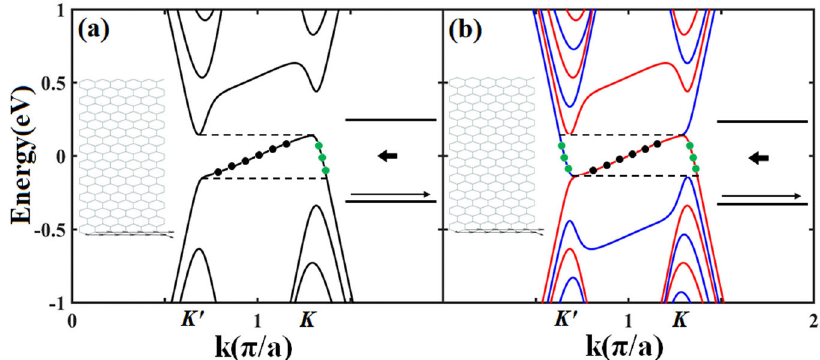
Fig. 6 The band structure of one case of Type-2. a U 1 = 0.2 t . b M 1 = 0.2 t . Inset: local current distribution ( E = 0.03 eV) and schematic diagram of corresponding edge states. The black bands (arrows) denote the spin degeneracy case, and the red (blue) bands denote the spin-up (down) case. Other fi xed parameters are the same as in Fig. 2.